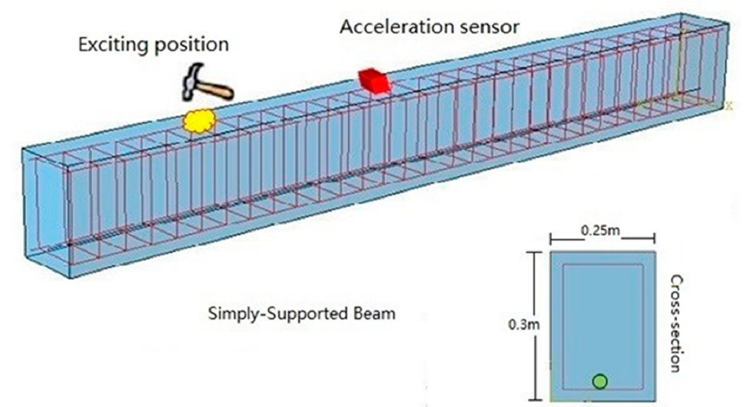
Table 2. Different impact loading conditions.